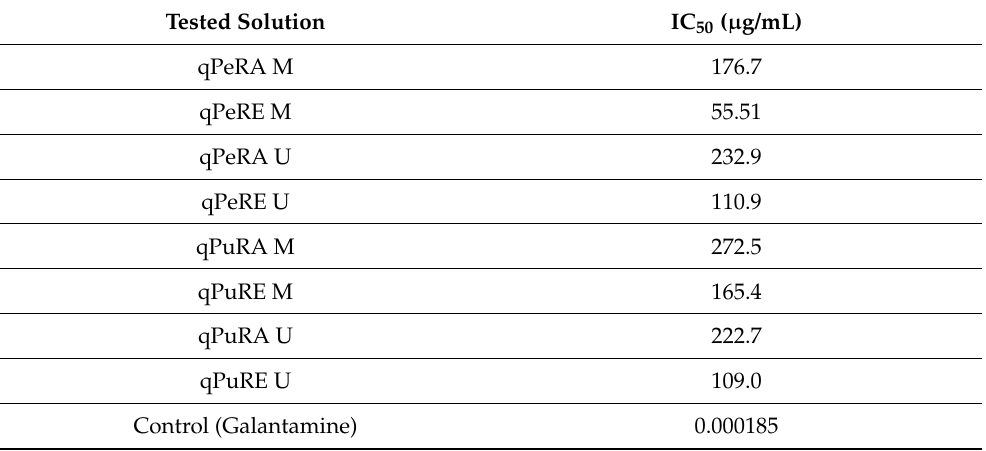
Table 5. IC 50 values for the tested solutions against